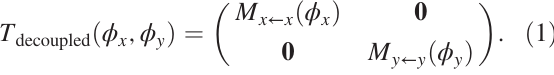
, and the blue th